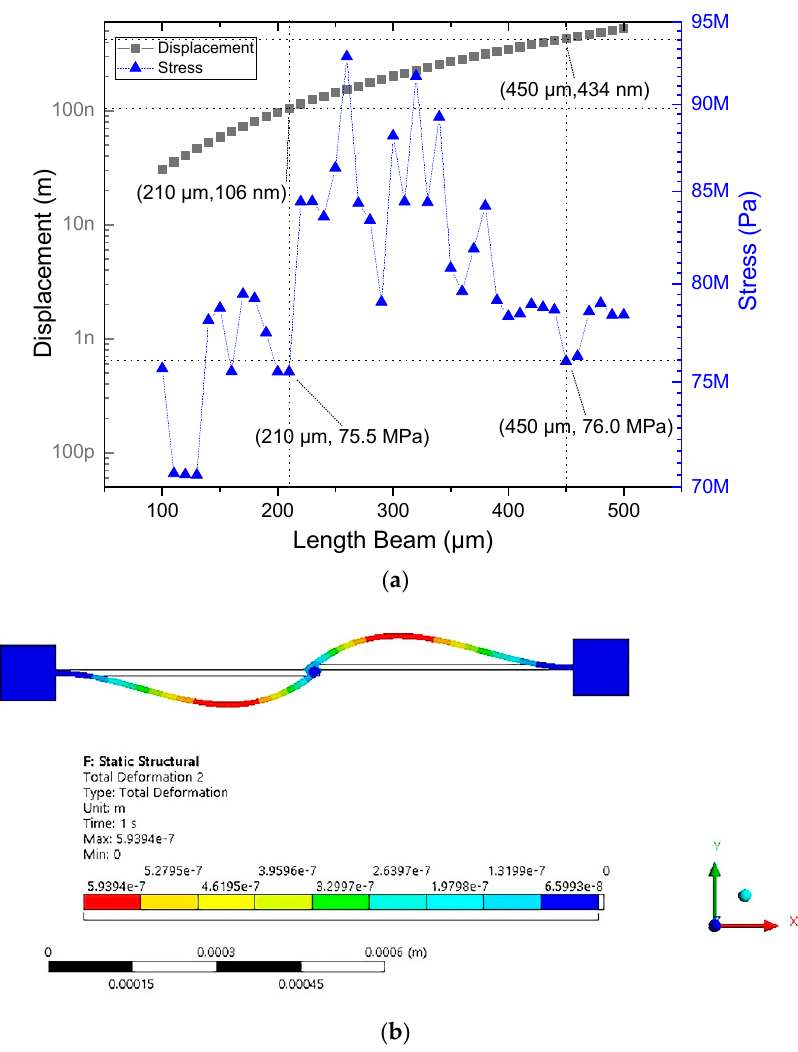
Figure 5. Improved geometric dimensions of the microactuator with 2 beams. ( a ) Parameterization of the beams lengths, and ( b ) simulation of the microactuator with the improved geometrical length.